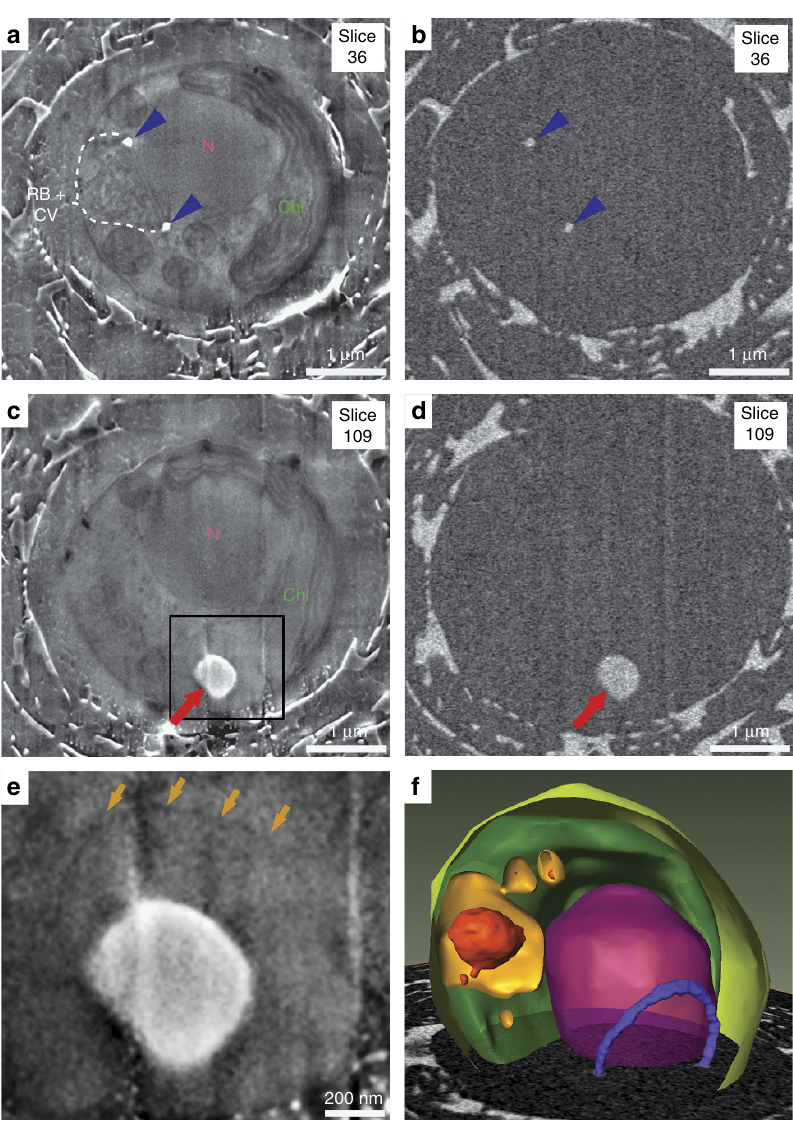
Figure 3 | Cryo-FIB-SEM imaging of vitrified E. huxleyi reveals coccolith calcite and calcium-rich bodies in separate compartments. ( a – d ) Two slices from the same cell acquired with in-lens secondary electron detector ( a , c ) and energy selective backscattered electron detector ( b , c ) showing a cross-sectioned coccolith in statu nascendi (blue), the Ca-rich body (red), the coccolith vesicle (CV)–reticular body system (RB), the nucleus (N) and the chloroplast (Chl). Additional organelles are visible in the secondary electron images as is shown in Supplementary Fig. 3. ( e ) Oversampled and contrast- enhanced magnification of the area framed in c , illustrating the membrane that encloses the Ca-rich body (arrows). ( f ) 3D reconstruction of an E. huxleyi cell from a cryo-FIB-SEM image series, showing the nucleus (violet), chloroplast (dark green), plasma membrane (light green), a coccolith in statu nascendi (blue), Ca-rich bodies (red) and the membranes encompassing Ca-rich bodies (orange). Figure is accompanied by Supplementary Video